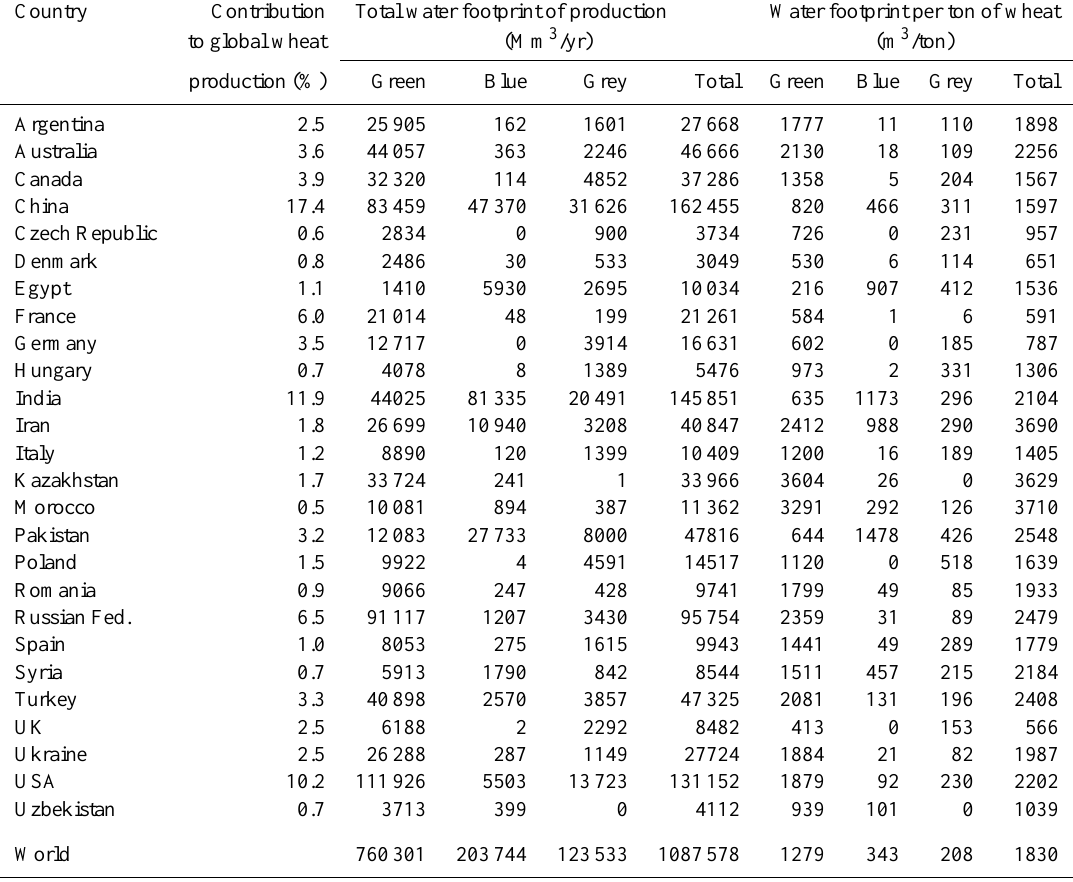
Table 1. Water footprint of wheat production for the major wheat producing countries. Period: 1996–2005.